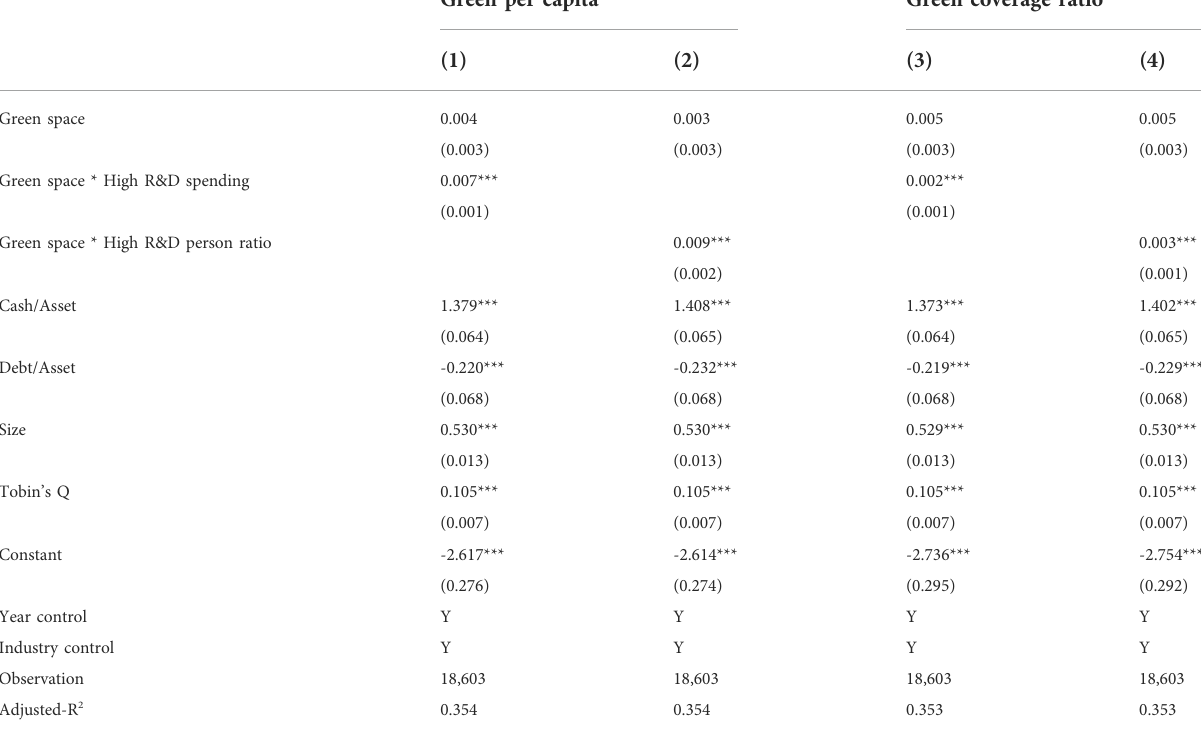
TABLE 6 R&D dependence and the effect of urban public green